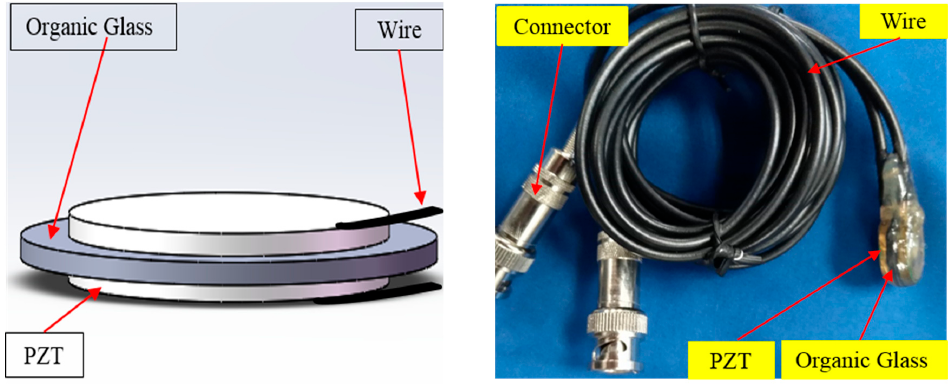
Figure 5. The piezoceramic disk transducers.